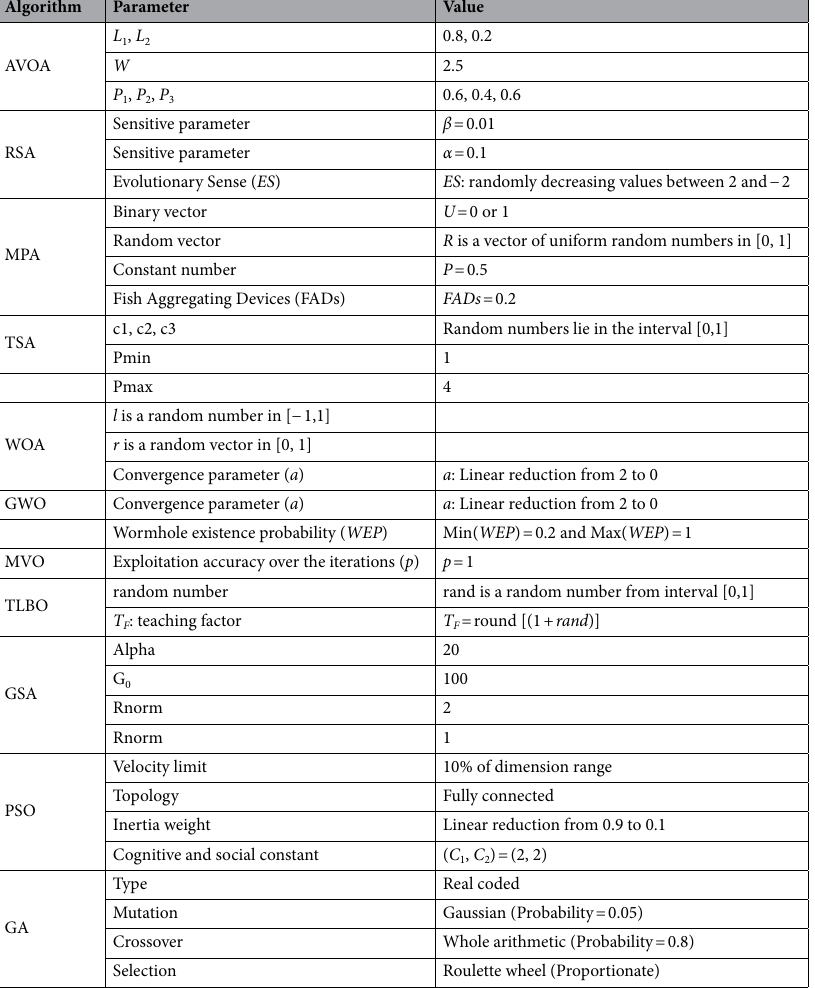
Table 2. Assigned values to the control parameters of competitor